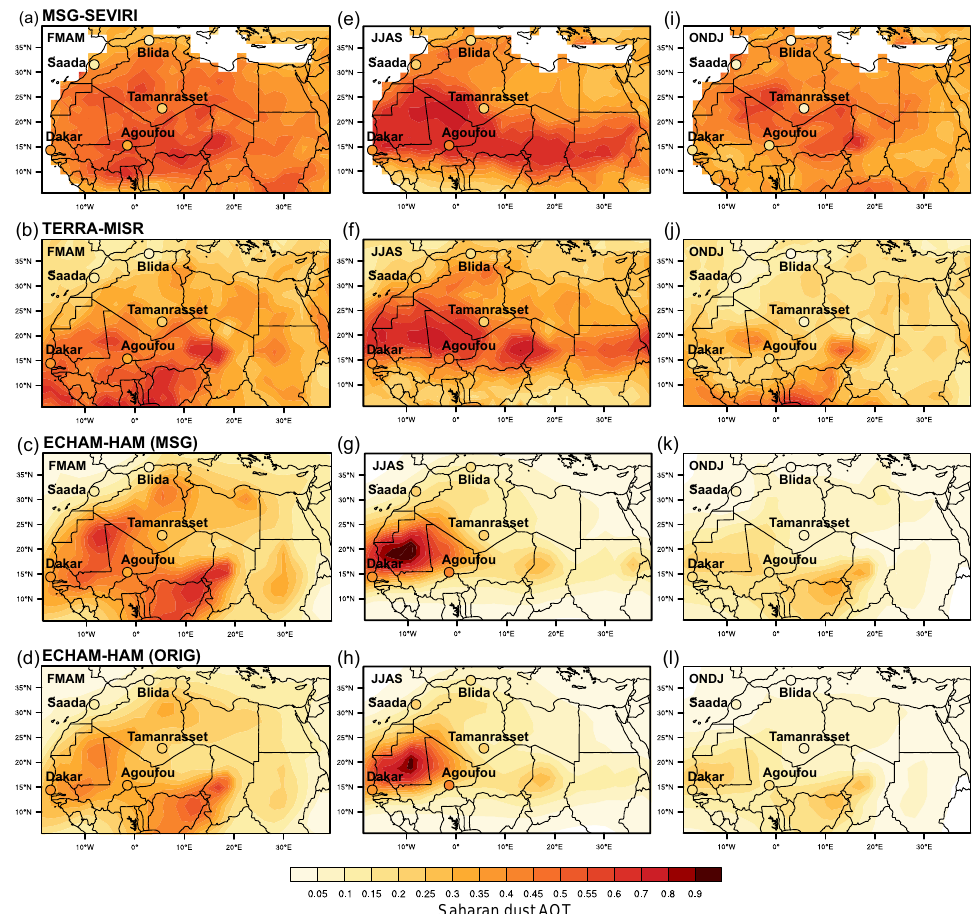
Figure 6. Saharan dust optical thickness for the year 2008, averaged over the months (a–d) February–May, (e–h) June–September, and (i–l) October–January. Compared are (a, e, i) values of dust AOT from MSG-SEVIRI, (b, f, j) the TERRA-MISR AOT, and results from ECHAM-HAM model runs with the (c, g, k) MSG-based and (d, h, l) original setup. Color-coded dots show the corresponding average of the 500nm coarse-mode AOT measured at AERONET